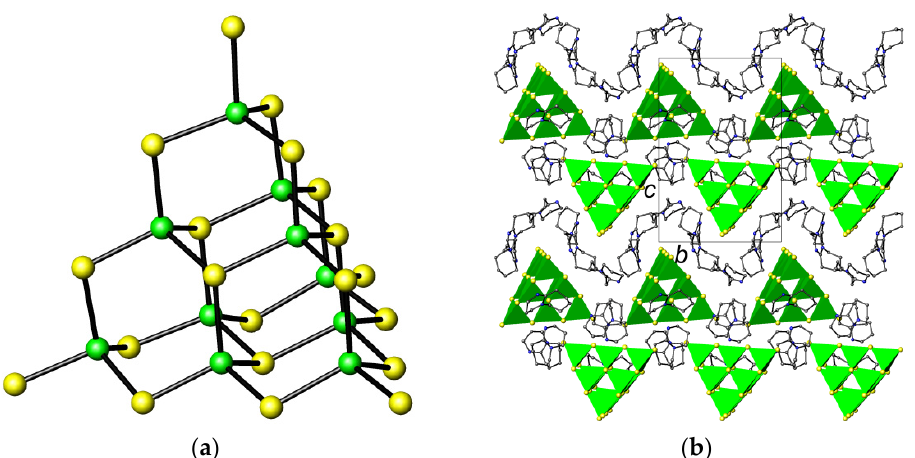
Figure 1. ( a ) The T3 supertetrahedral cluster found in [C 9 H 17 N 2 ] 6 [Ga 10 S 16 (SH) 4 ]. Color key: green spheres, Ga; yellow spheres, S. ( b ) View of the crystal structure along the a -axis. Unit cell is shown. Color key: GaS 4 , green tetrahedra; yellow spheres, S; blue spheres, N; grey spheres, C. H atoms have been omitted for clarity.